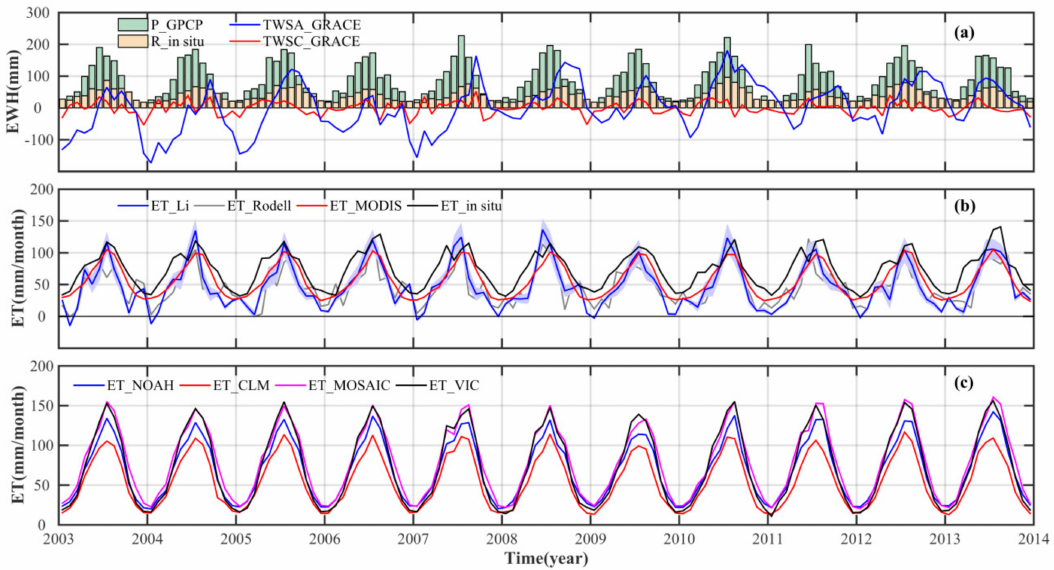
Figure 5. ( a ) Time series of monthly precipitation and runoff from the Datong gauge station, and TWS estimated from GRACE; ( b , c ) ET estimations based on different methods or products over the entire YRB. ET_NOAH, ET_CLM, ET_MOSAIC, and ET_VIC are the ET results obtained from the Global Land Data Assimilation System (GLDAS) products of the four land surface models (LSMs) (Noah, CLM, Mosaic, and VIC), and ET_ MODIS and ET_ in situ are the ET results from Moderate Resolution Imaging Spectroradiometer (MODIS) and in situ observations,